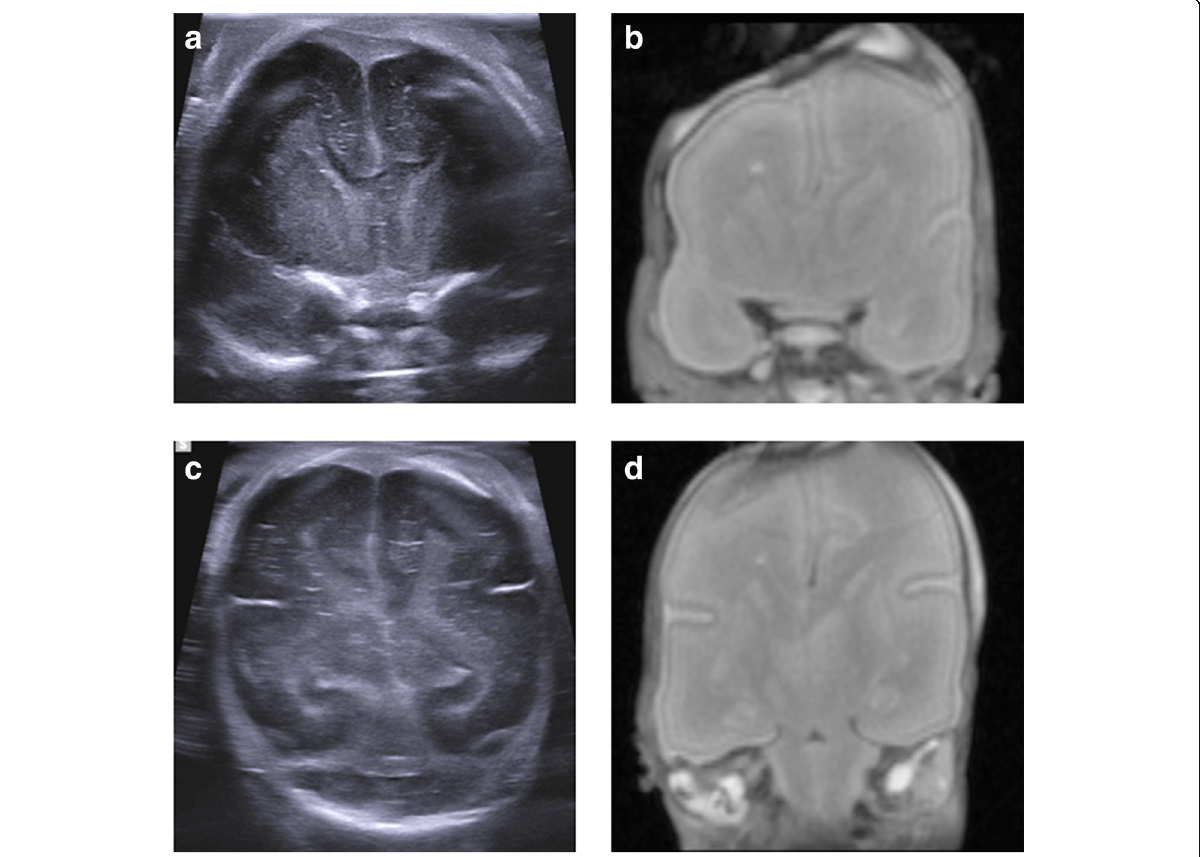
Fig. 3 Paired coronal postmortem ultrasound images (obtained in the water bath) and T2-weighted postmortem MRI at 1.5 T in the same 20- week gestational-aged foetus. The images were obtained 4 days after death, demonstrating normal anatomy. Images through the frontal horns ( a , b ) and the posterior horns ( c , d ) of the lateral ventricles demonstrate how detailed anatomy of the brain, including sulcation and appearances of the ventricles can be adequately reviewed by ultrasound, and not necessarily require further cross-sectional